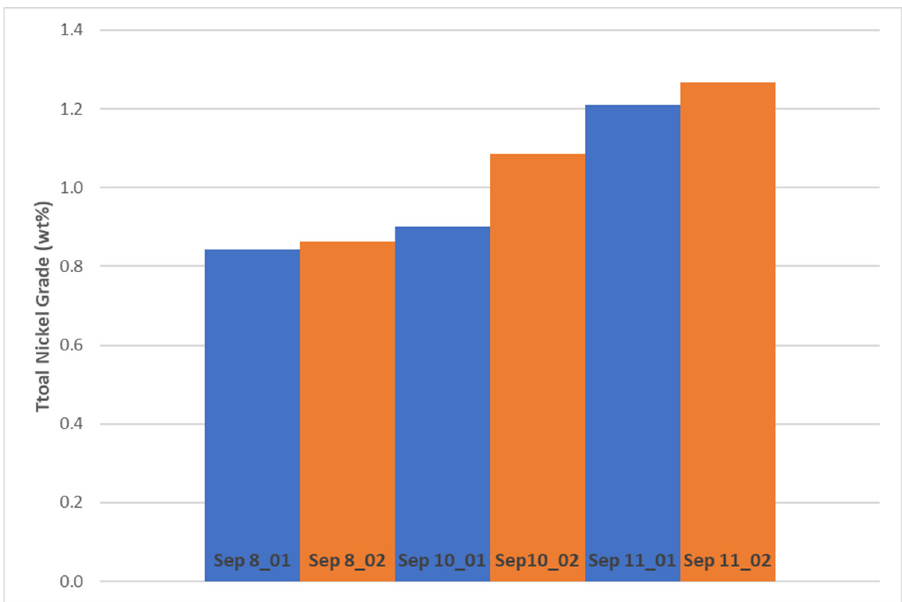
Figure 5. Total nickel grade in Ni rougher-scavenger concentrate using process water without (01) and with (02) DAF treatment.